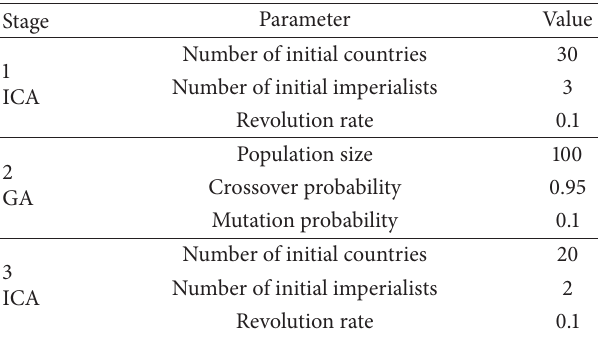
Table 2: Parameter specification in computer